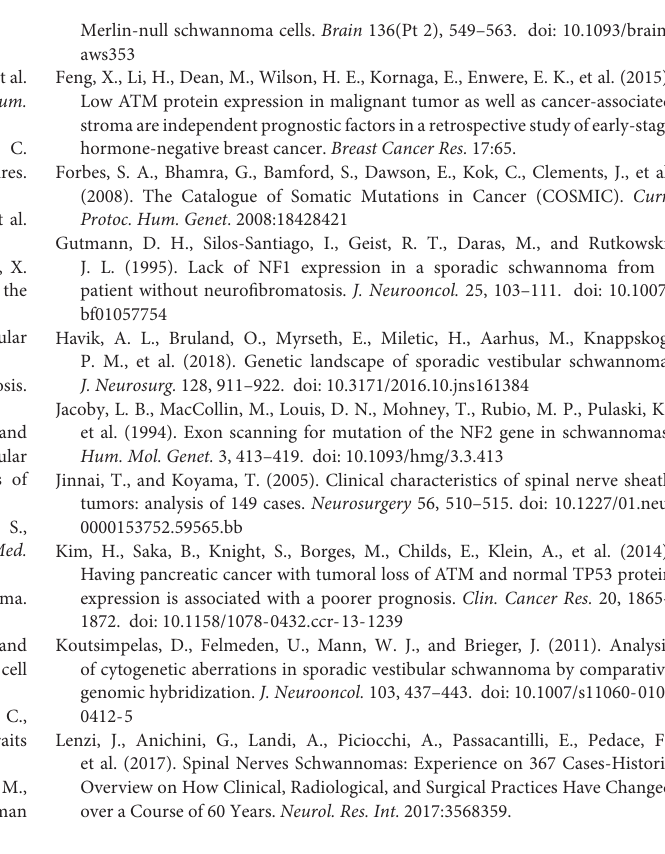
Supplementary Figure 1 | The coverage and B allele frequency of chromosome 22 in samples of CHG004878, CHG004880, CHG004884, and CHG004888. The whole chromosome loss in chr22 was observed in samples CHG004878, CHG004880, and CHG004884, but the CHG004888 was found to have focal deletion adjacent to NF2. The position of NF2 in chr22 was highlighted by blue boxes. Supplementary Figure 2 | The read alignment of NF2 mutations in CHG004880 and CHG004884 by integrative genomic viewer (IGV). Supplementary Figure 3 | The high resolution version of Figure 3B